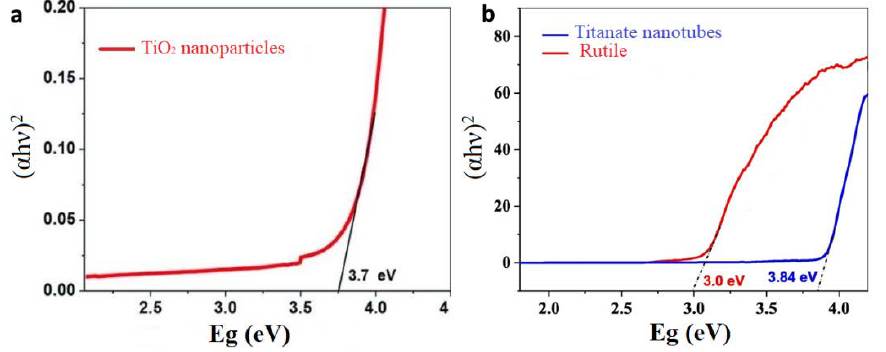
Figure 5. Tauc plots of ( a ) TiO 2 nanoparticles ( b ) Titanate nanotubes and rutile.